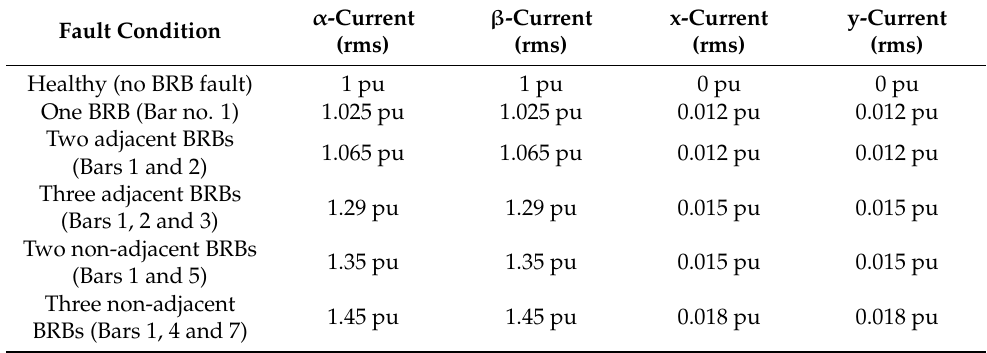
Table 2. Sequence rms currents in various BRB fault conditions. Fault Condition